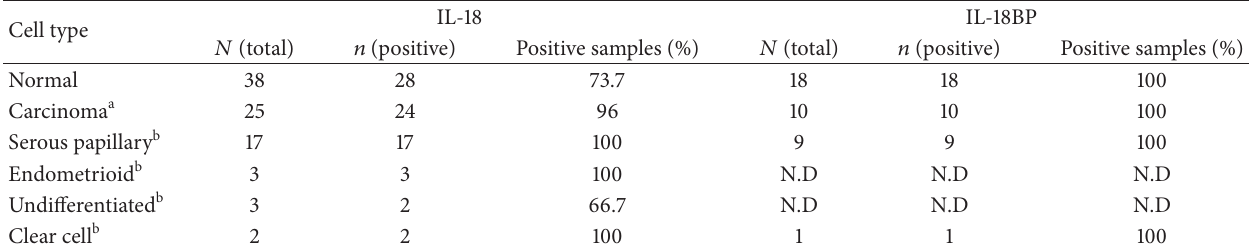
Table 1: IL-18 and IL-18BP expression in normal and cancerous ovarian tissue